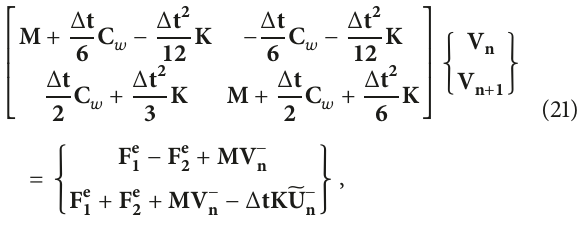
Figure 2: Comparison of the temperature profiles at 𝑡 = 0.16 , 𝑡 = 0.20 , 𝑡 = 0.22 , and 𝑡 = 0.26 between the proposed DGFEM and the Newmark